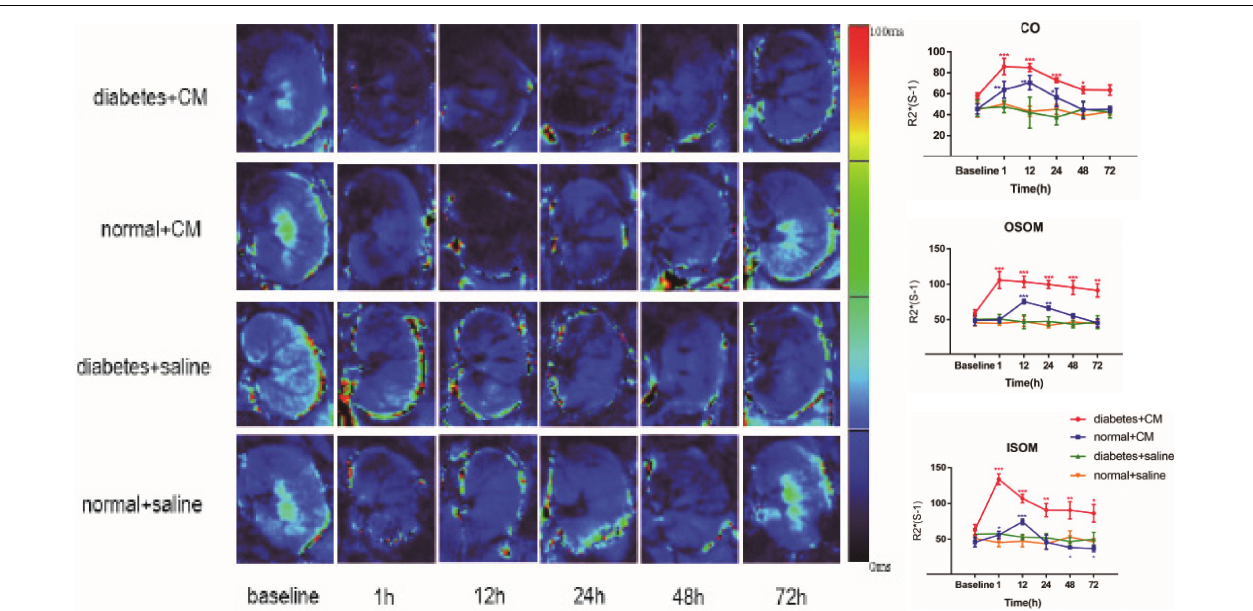
FIGURE 3 | Parametric images of BOLD images. Four groups of images from up to down are the representative T2* images. Group A Diabetes+CM, Group B Normal+CM, Group C Diabetes+saline, Group D Normal+saline. The parameter stands for T2* in these images which are transferred to its reciprocal R 2 * in the following three line charts. (Compared with baseline, * P < 0.05, ** P < 0.005, *** P < 0.0001). CO, Cortex; OSOM, outer stripe of the outer medulla; ISOM, inner stripe of the outer medulla; CM, contrast medium; BOLD, blood oxygenation